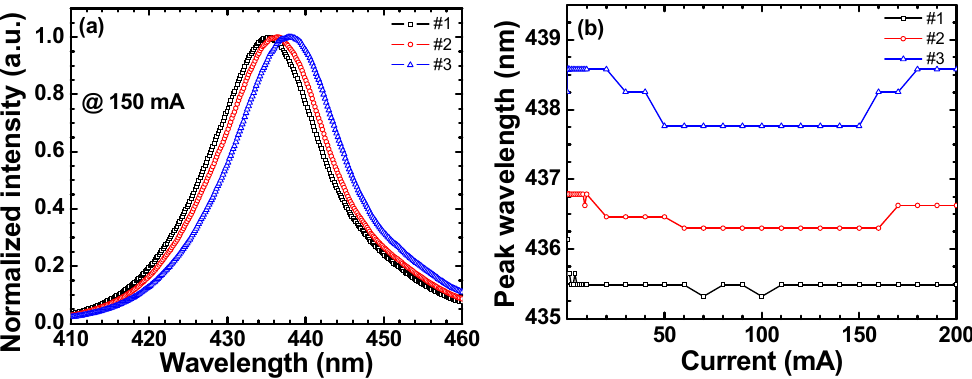
Figure 2. ( a ) Normalized EL spectra at 150 mA and ( b ) peak wavelengths as a function of current.